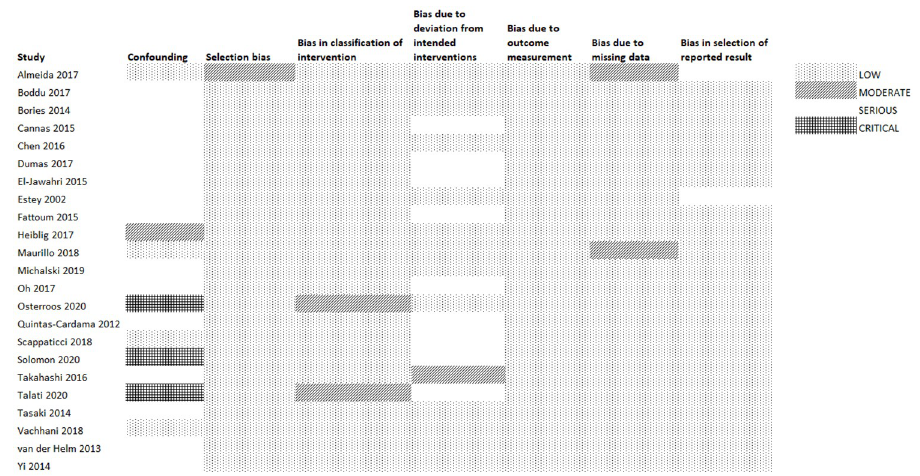
Fig 2. Risk of bias in observational studies.